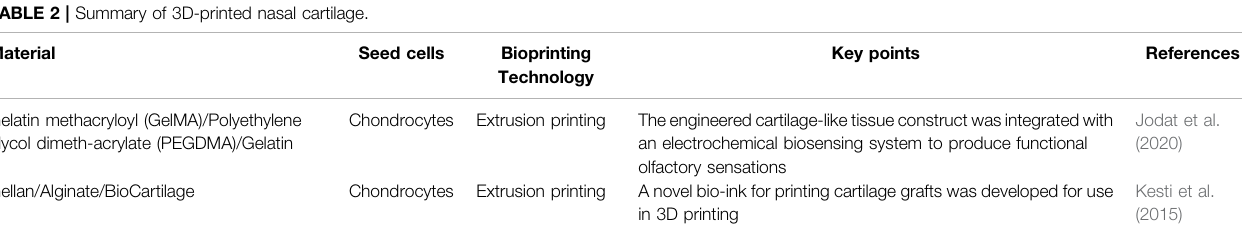
TABLE 2 | Summary of 3D-printed nasal